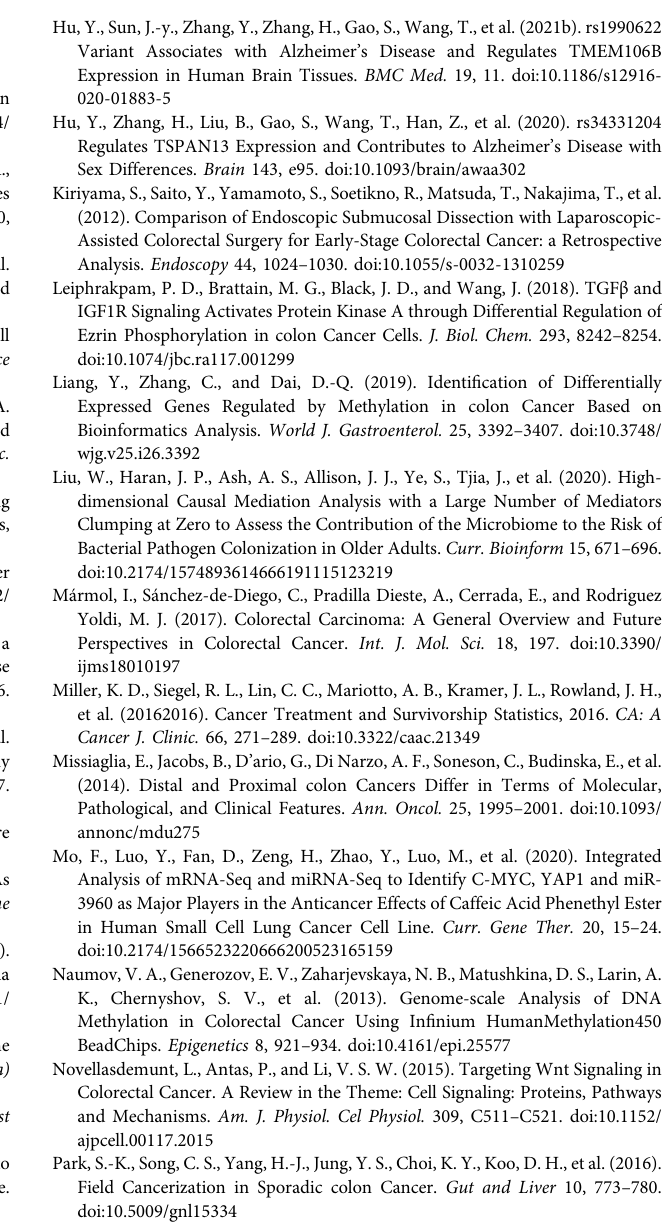
Supplementary Figure S3 | The results of KEGG pathway enrichment analysis for downregulated expressed genes in colon cancer and subtypes.